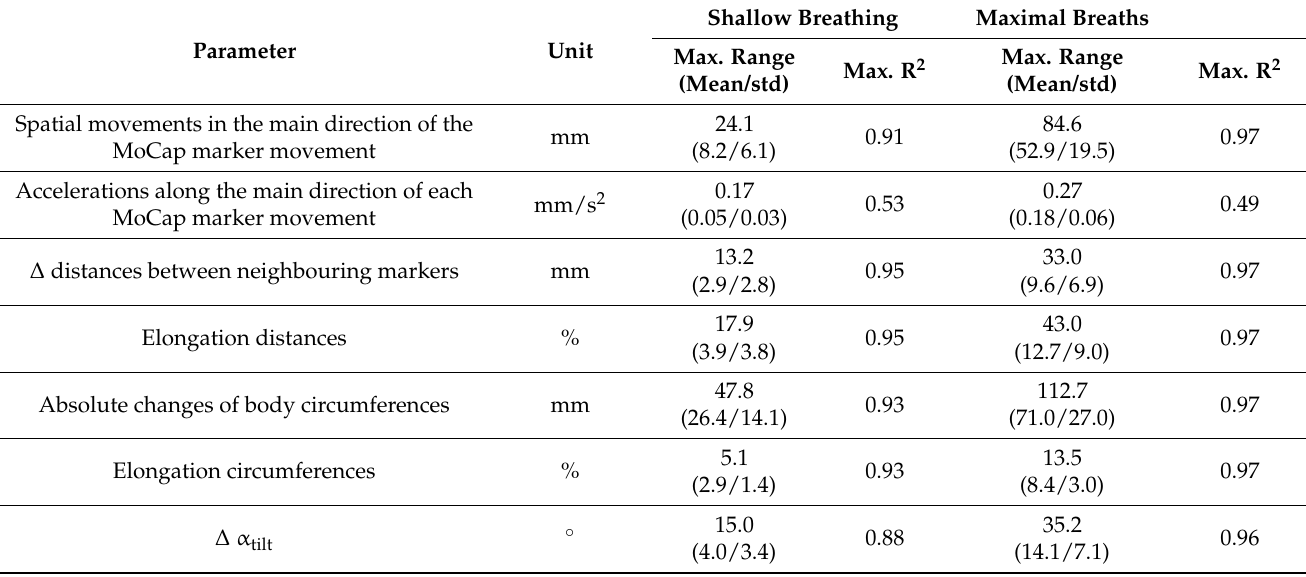
Table 4. Ranges and correlations of the determined movement